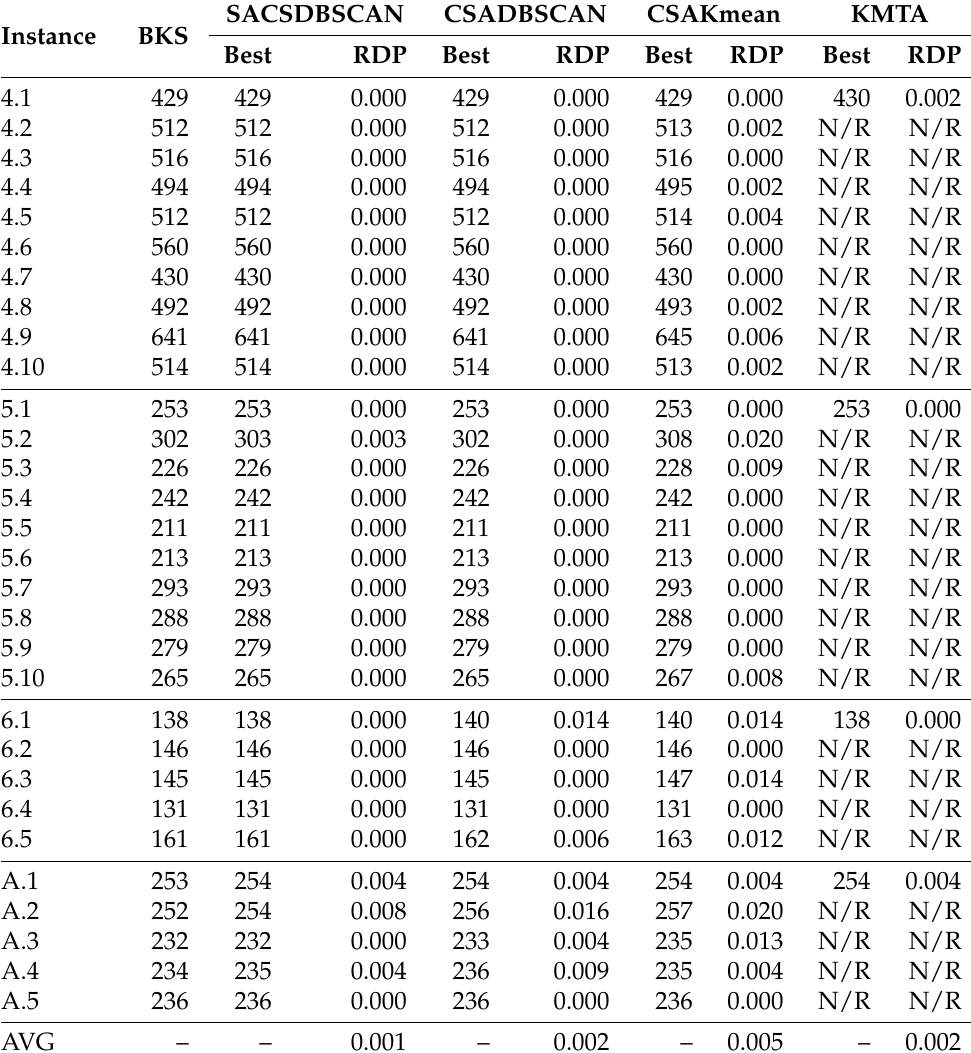
Table 20. Best values reached by an improved bio-inspired algorithm with ML that solve the set covering problem Instances 4, 5, 6 and